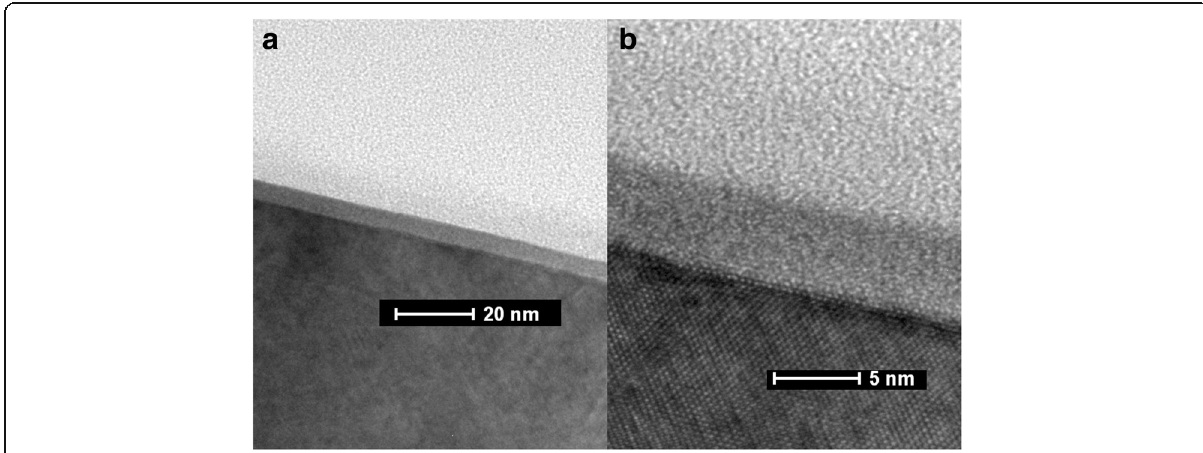
Fig. 3 HR-TEM images of as-grown HfAlO thin films on InP substrate, with a low magnification and b high resolution